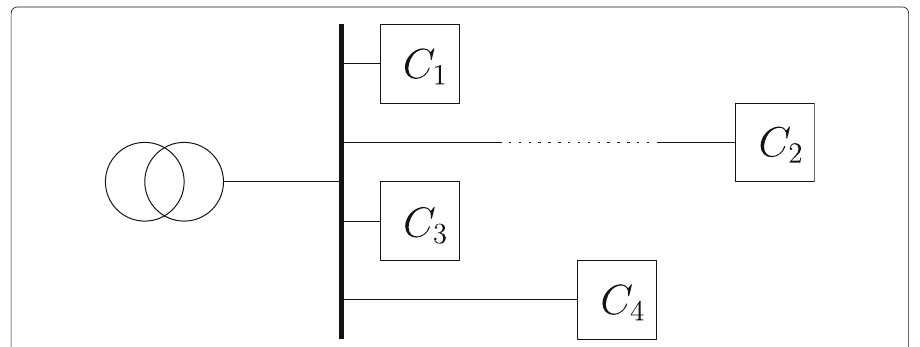
Fig. 7 Schematic location of the four charging station in the tested grid